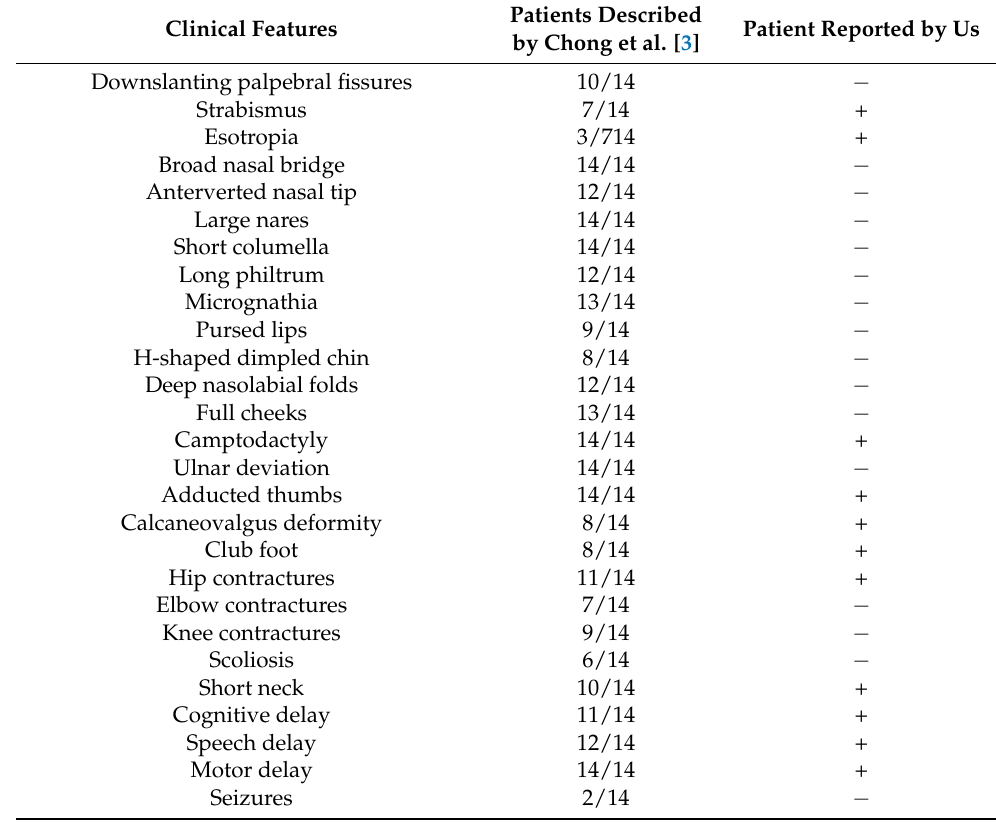
Table 2. The comparison of the clinical symptoms described by Chong et al. [3] with the patient’s symptoms with a novel c.1807G > C, p.(Glu603Gln) variant in the NALCN